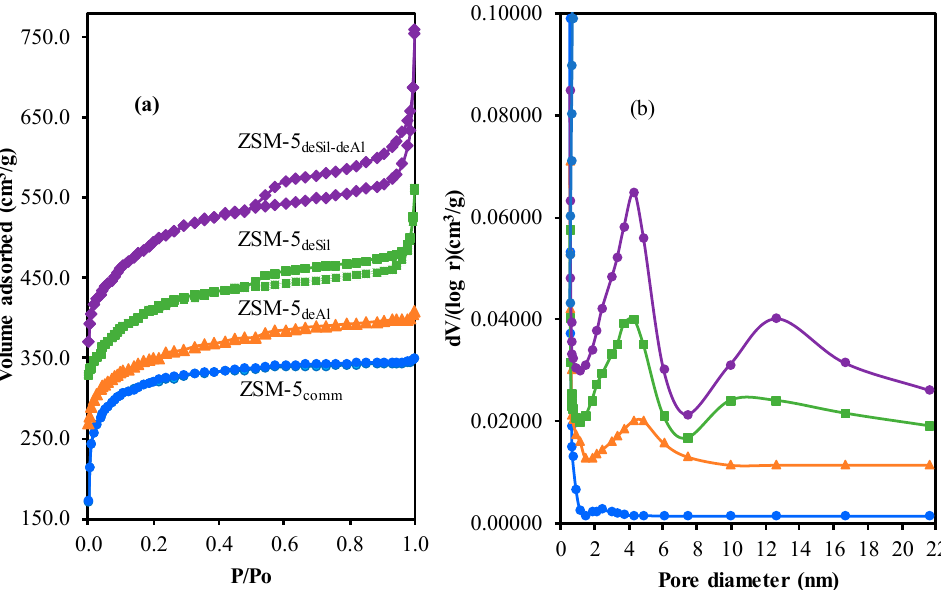
Figure 2. ( a ) N 2 isotherm adsorption desorption of the adsorbent, ( b ) pore size distributions of adsorbents. Table 1. Surface area and pore volume of the adsorbents.